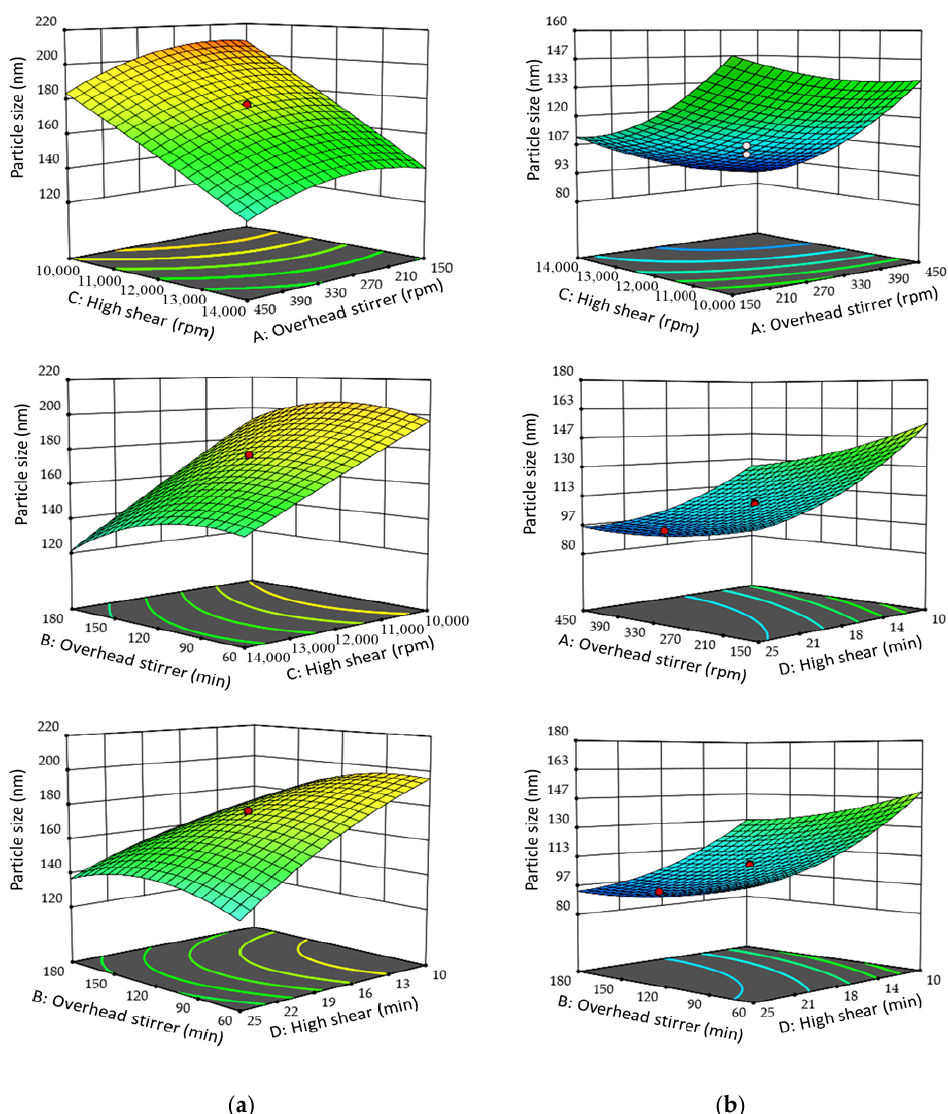
Figure 2. Three-dimensional response surface plot of ( a ) DTX-loaded nanoemulsion and ( b ) CCM- loaded nanoemulsion process parameters on the z-average hydrodynamic diameter (particle size). The models show the interaction between independent variables including A: Overhead stirrer speed (rpm); B: Overhead stirrer duration (min); C: High shear speed (rpm); D: High shear duration (min) toward the particle